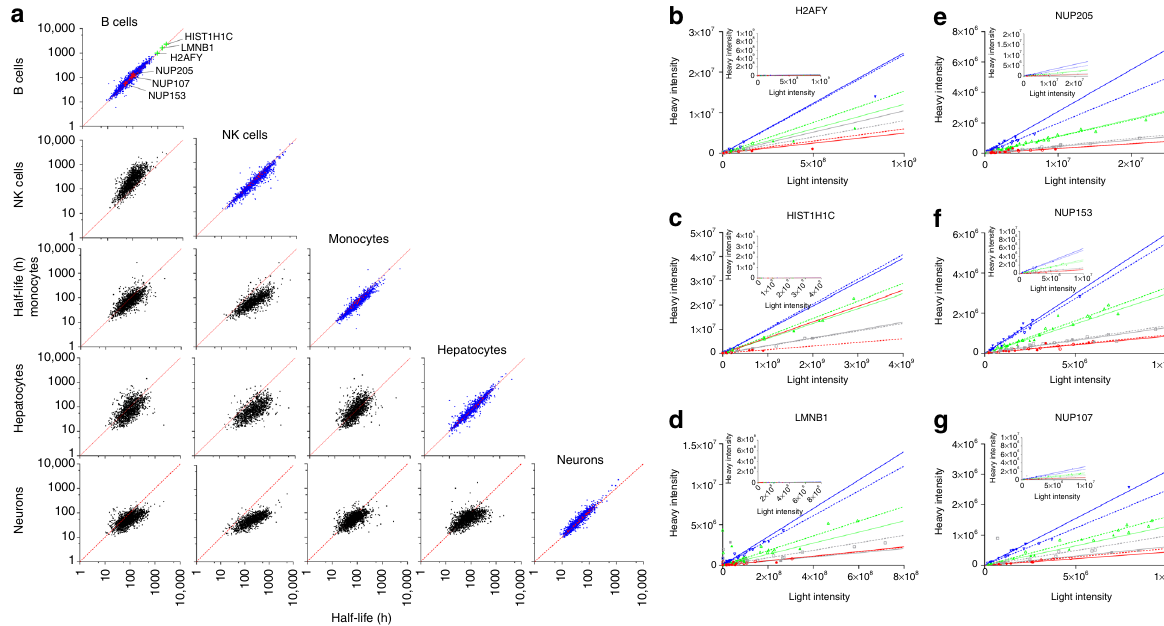
Fig. 2 Assessment of protein half-lives in different cell types. a Scatter plots comparing protein half-lives determined in two experiments. On the diagonal the half-lives determined in biological replicate experiments in the same cell type are compared. Red dots indicate nuclear pore complex components. The plots below the diagonal compare the average protein half-lives determined in one cell type against other cell types as indicated. b, c, d Highly reproducible individual peptide fold changes from proteins with very-long half-lives determined from the B-cell experiment. The median protein fold changes are denoted by the slope of the line. The fold changes at the different time points are denoted by the different colors (red, 7 h; gray 11 h; green 24 h, and blue 34 h) with replicate one represented by a solid line and replicate two by a dashed line. The insets on each graph show the heavy and light SILAC intensities plotted on the same scale. b O75367 (Core histone macro-H2A.1, H2AFY) half-life from replicate one/two 945.9/995.9 h. c P16403 (Histone H1.2, gene HIST1H1C) half-life from replicate one/two: 2168.8/2315.5 h. d P20700 (Lamin-B1, gene LMNB1) half-life from replicate one/two: 1479.9/1623.5 h. The same is shown for three nuclear pore complex members (NUPs) as for ( b , c , d ). e Protein NUP205 has a half-life of 103.3 h in replicate one and 138.9 h in replicate two. f Protein NUP153 (P49790) has the shortest half-life of all the NUPs identi fi ed in B-cells with a half-life of 49.8 h in replicate one and 55.1 in replicate two. g Protein NUP107 (P57740) has a half-life of 91.2 h in replicate one and 104.5 h in replicate complex, for which a half-life of 192 h was determined in the mouse brain. In our mouse embryonic neuron data, the median